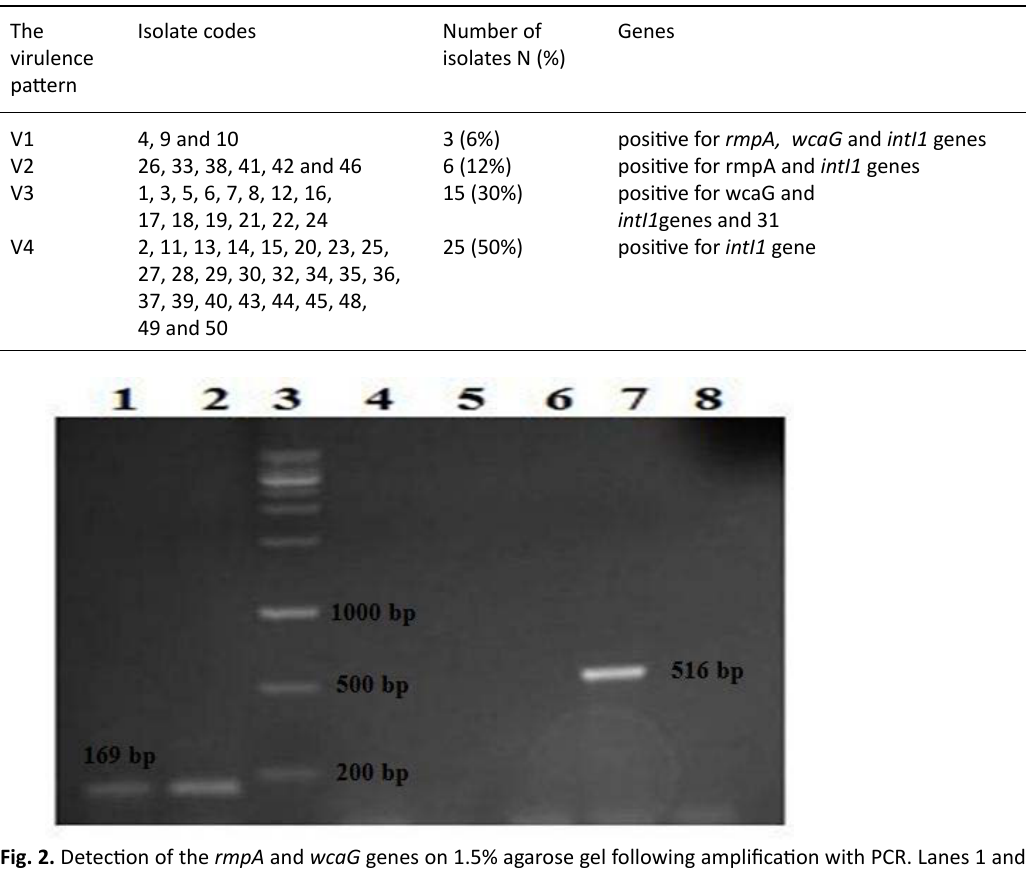
table 3. Virulence patterns of the 49 K. pneumoniae isolates